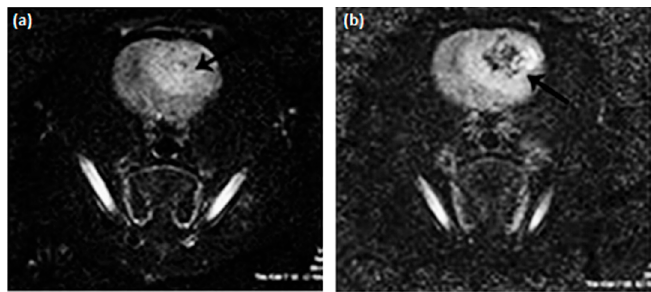
Figure 7. In vivo T 2 -weighted MR pictures representing a rats’ brain with C6 gliomas (indicated by the arrows), acquired 48 h after the administration of ( a ) SPIONs and ( b ) Lf-SPIONs. Reprinted from Xie, H.; Zhu, Y.; Jiang, W.; Zhou, Q.; Yang, H.; Gu, N.; Zhang, Y.; Xu, H.; Xu, H.; Yang, X. “Lactoferrin-